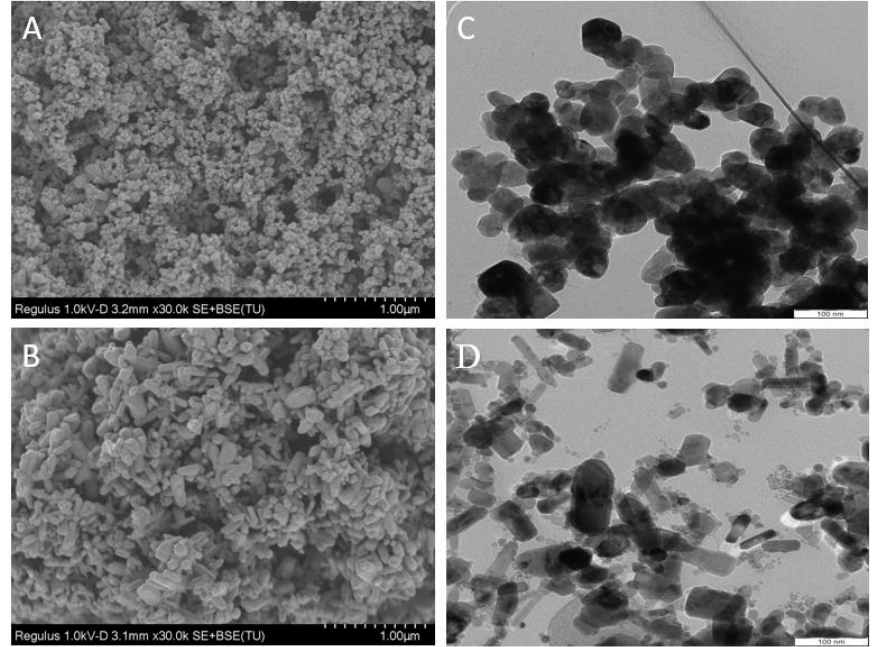
Figure 1. SEM images of ( A ) ZnO-R NPs and ( B ) ZnO Std NPs. TEM images of ( C ) ZnO-R NPs and ( D ) ZnO Std NPs.